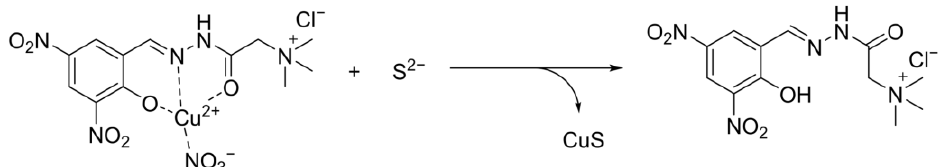
Figure 7. Absorbance spectra of HDHT –Cu 2+ complex (30 µ M) with different concentrations of S 2 − Figure 7. Absorbance spectra of HDHT – Cu 2+ complex (30 μM) with different concentrations of S 2− Figure 7. Absorbance spectra of HDHT – Cu 2+ complex (30 μM) with different concentrations of S 2− (0–54 µ M) (blue line: HDHT –Cu 2+ ; red line: HDHT –Cu 2+ + 51 µ M S 2– ). (0 – 54 μM) (blue line: HDHT – Cu 2+ ; red line: HDHT – Cu 2+ + 51 μ M S 2 – ). (0 – 54 μM) (blue line: HDHT – Cu 2+ ; red line: HDHT – Cu 2+ + 51 μ M S 2 – ). Figure 7. Absorbance spectra of HDHT – Cu 2+ complex (30 μM) with different concentrations of S 2− (0 – 54 μM) (blue line: HDHT – Cu 2+ ; red line: HDHT – Cu 2+ + 51 μ M S 2 – ).